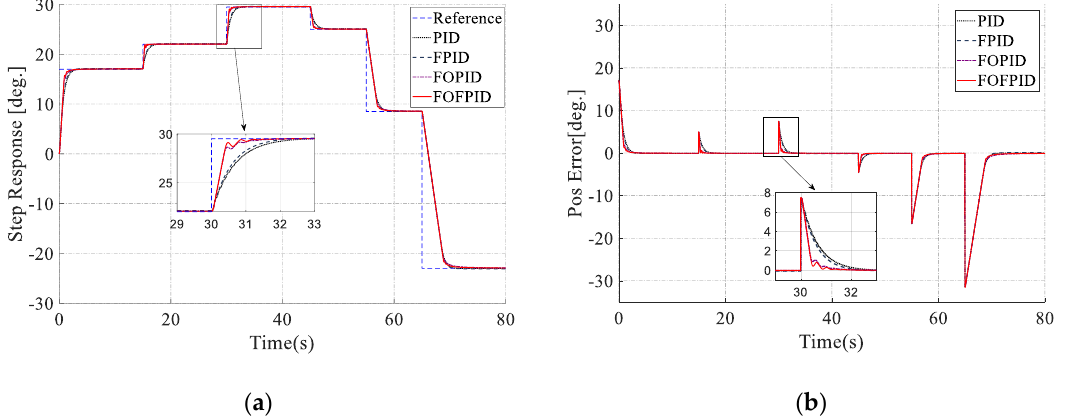
Figure 9. Comparison for multi-step trajectory (maximum amplitude 30 degrees and the payload is 500 N). ( a ) Output performance; ( b ) error effort.